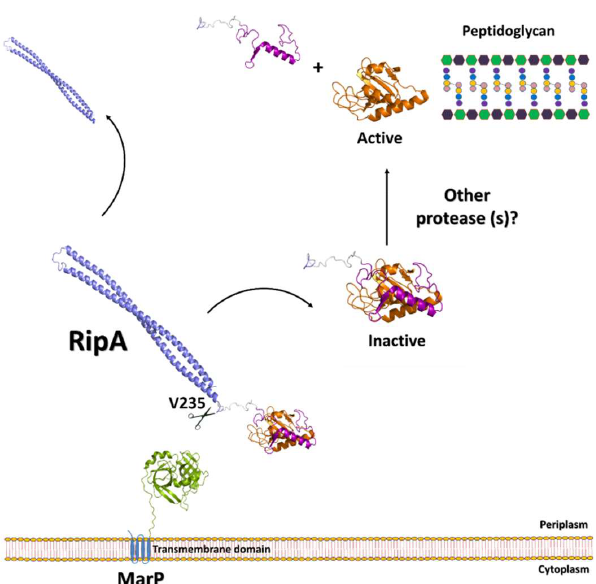
Figure 8. Regulation of RipA via proteolytic degradation by MarP. Given the site of hydrolysis, at position V235, a successive hydrolysis is needed to activate RipA.